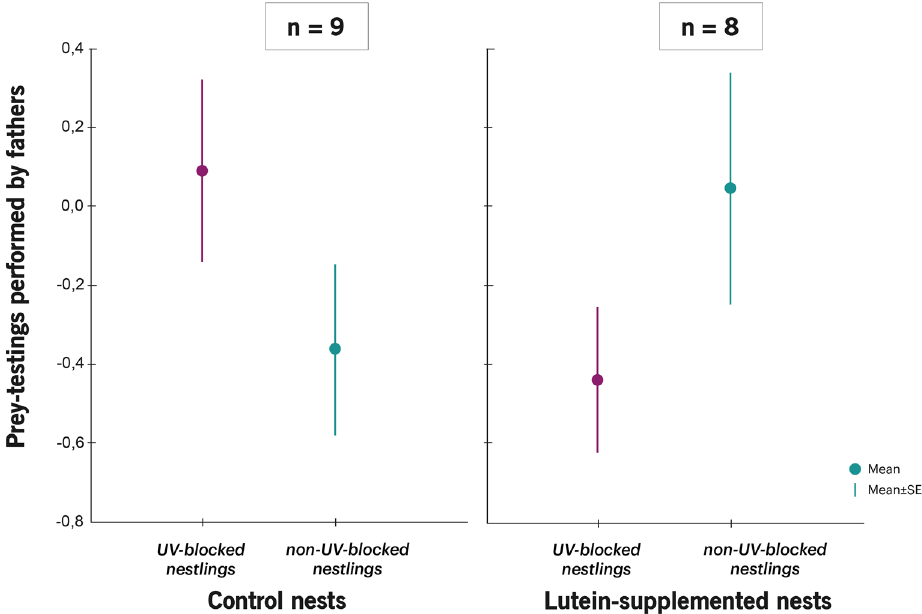
Figure 2. Difference (mean ± SE) in prey-testings performed by males (Post UV manipulation − Prior UV manipulation) according to nestling UV colour manipulation and female supplementation treatment. Values are (mean ± SE) residuals plus the average difference in male prey-testings from a model that includes all variables except the interaction between both treatments. Sample sizes for control females and lutein-supplemented females are shown.